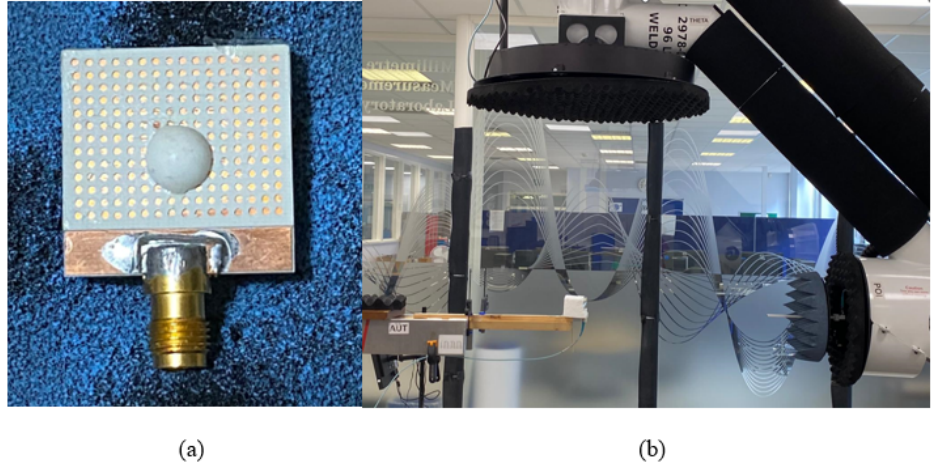
Figure 18. Integrated hemispherical DRA and a perforated substrate ( a ) Assembled ( b ) In the anechoic